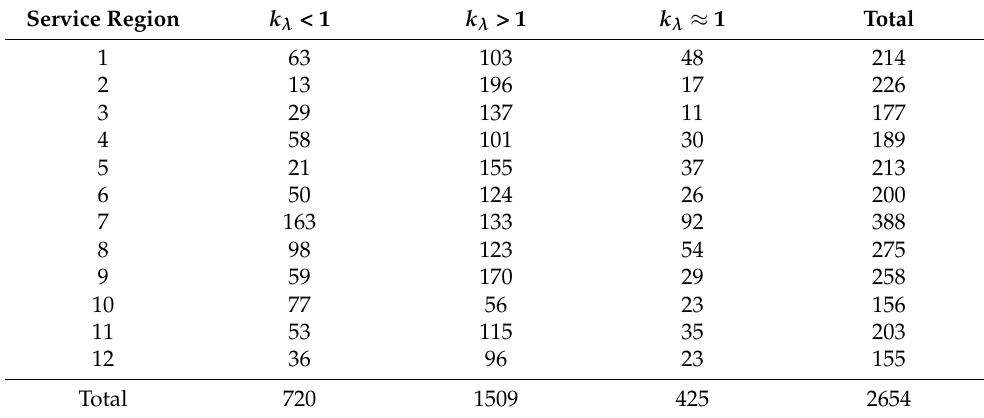
Table 3. Number of feeders with different types of failure rate tendencies in each service